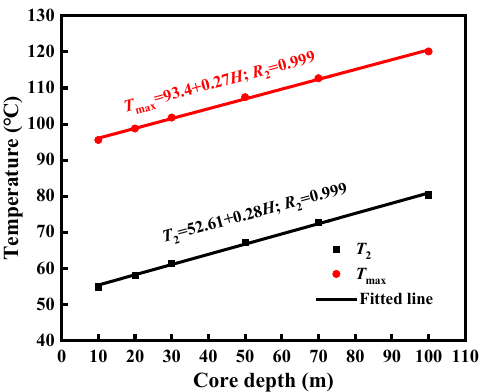
depth, which is shown in Figure 21.